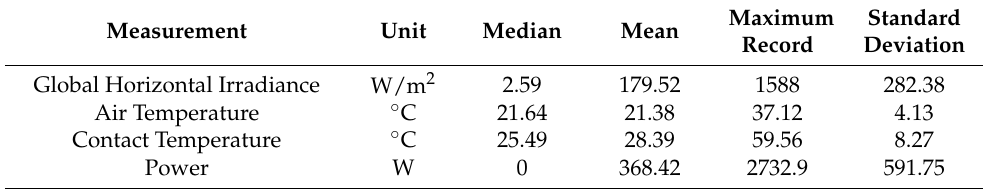
Table 3. Dataset descriptive statistic.